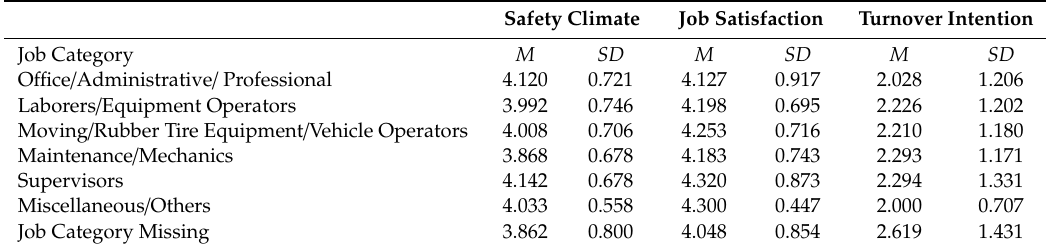
Table 1. Descriptive statistics by job